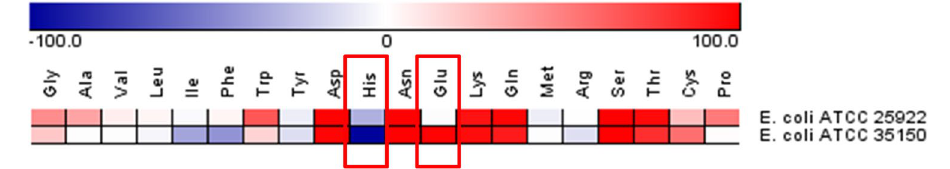
Figure 5. Comparative consumption of AAs between E. coli strains with and without toxigenicity. Consumption patterns of wild-type E. coli (ATCC 25922) and Shiga toxin-producing E. coli (ATCC 35150) are shown by heat map. These two strains have a big difference in consuming His and Glu.